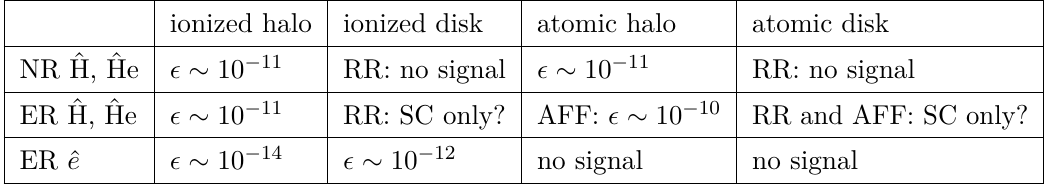
Table 4 . Summary of projected sensitivities to dark photon mixing (cid:15) from direct detection of mirror baryons and electrons via nuclear recoil at SuperCDMS HV Ge, and via electron recoil at SENSEI (or a hypothetical superconductor detector). Here we assume r with r − 1 / 2